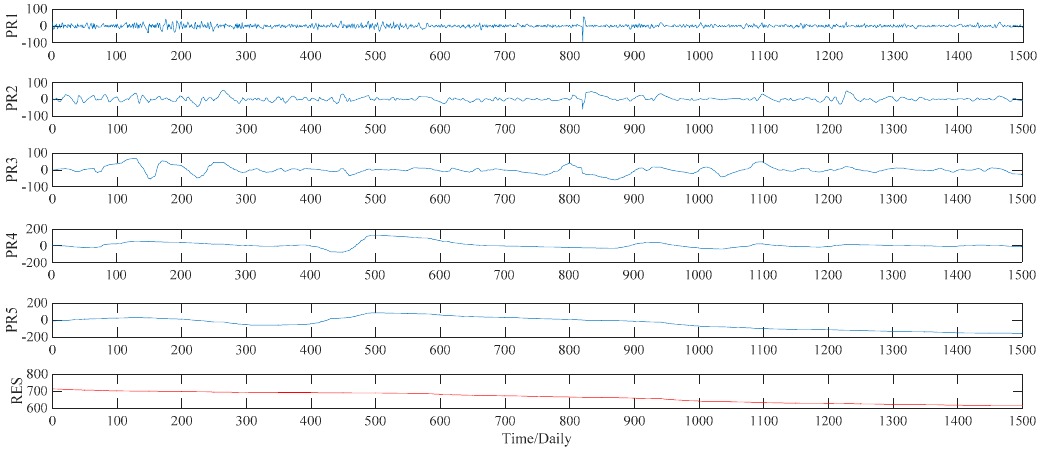
Figure 9. Decomposition results of the intrinsic time-scale decomposition (ITD) method (wheat).